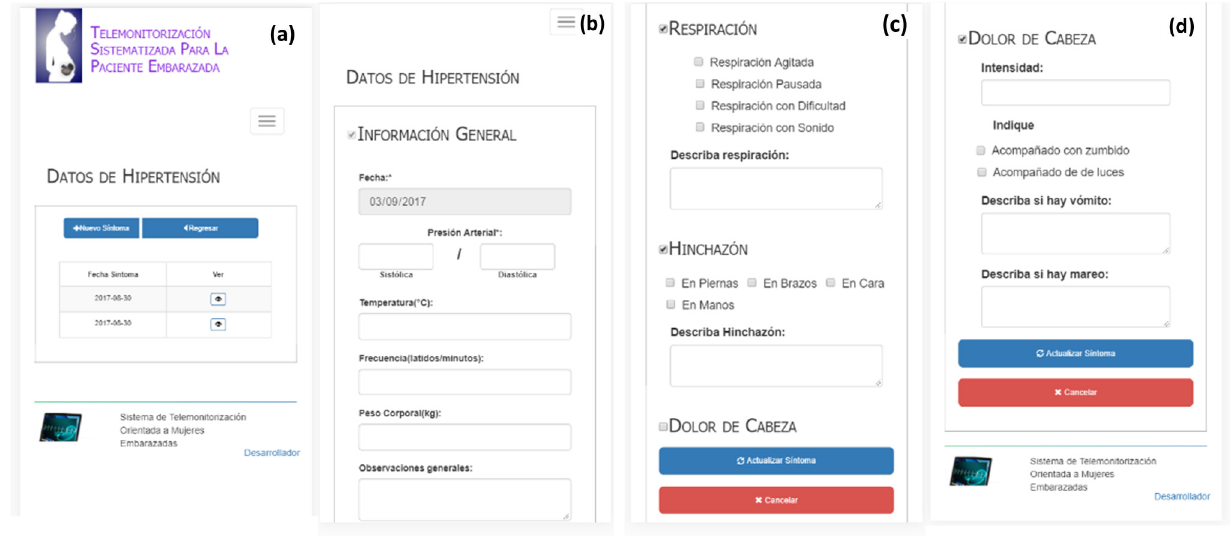
Figure 5. Hypertension symptom data (from left to right): ( a ) list, ( b ) general information, ( c ) breath- ing and swelling data, and ( d ) headache data.